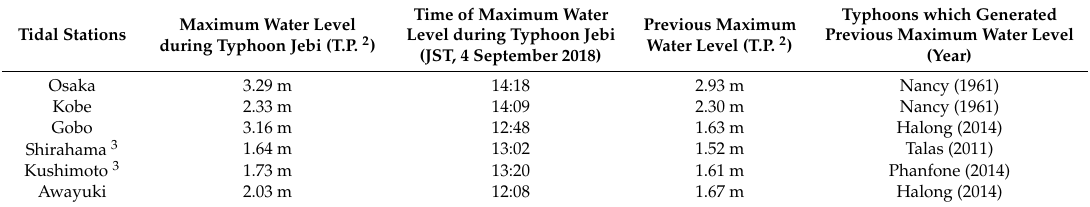
Figure 1. Most notable storm tracks to affect Osaka Bay area. Best track data for Jebi and Nancy are from Japan Meteorological Agency (JMA) [1,2], while Jane and Muroto’s are from NOAA’s IBTrACs database [3]. Note that there is no pressure information for Muroto’s track data. Table 1. Comparison of the maximum tidal levels recorded during Typhoon Jebi and past events 1 . The previous maximum water level was obtained from JMA [1].